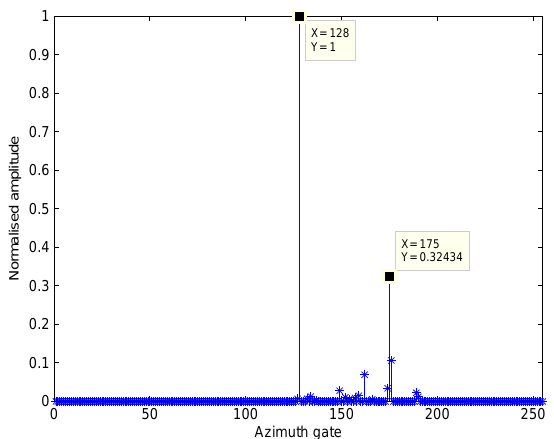
Figure 5. The influence of cross-track velocity on SAR